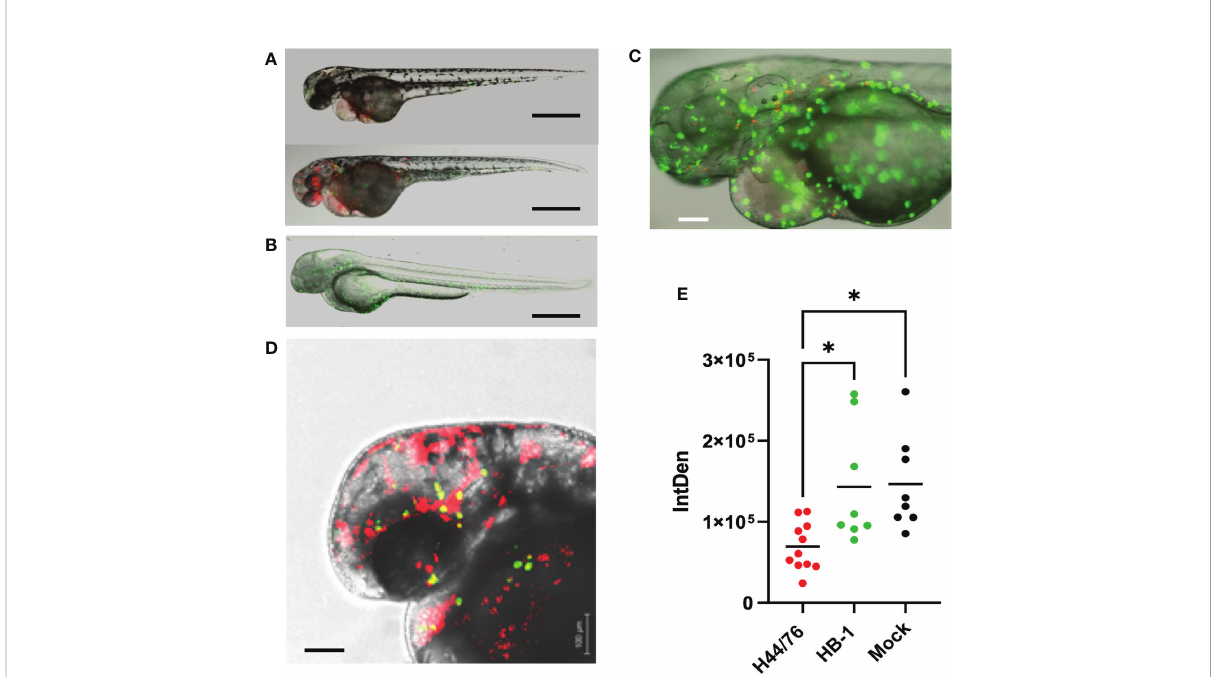
FIGURE 4 Fluorescence microscopy of H44/76 meningococci expressing mCherry (red fl uorescence) and neutrophils expressing GFP (green fl uorescence) in zebra fi sh embryos. (A) . H44/76 infected embryos at 24 hpi, Bar represents 100 m m. (B) . HB-1 infected embryo at 24 hpi. (C) . Detail of H44/76 infected embryo showing green fl uorescent neutrophils and red fl uorescent meningococci. (D) Detail of H44/76 infected embryo showing green fl uorescent neutrophils and red fl uorescent meningococci in the embryo head. Yellow color shows overlap between meningococci and neutrophils.Scale bars represent 100 m m. (E) Number of neutrophils in zebra fi sh embryos 24hpi of N. meningitidis H44/76 serogroup B (1400 cfu) or non-encapsulated HB-1 (1600 cfu) and mock-infected; 11 embryos infected with H44/76, two groups of 8 embryos infected with HB-1 or mock infected, respectively. IntDen = Integrated density of the green fl uorescence signal in the area of interest. * P = <